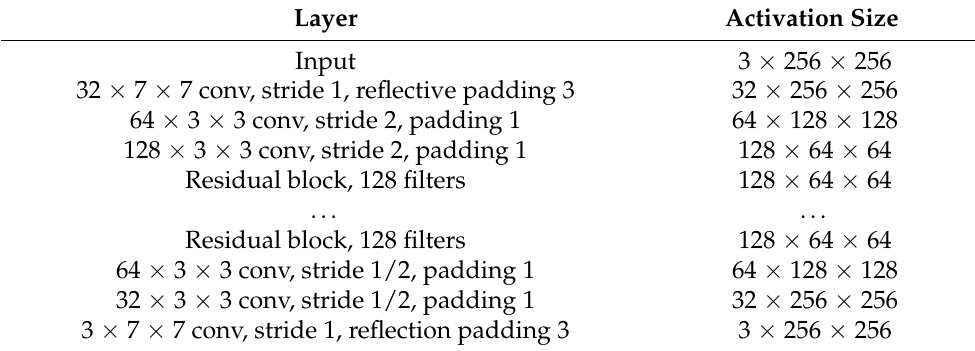
Table 1. Architecture of generator